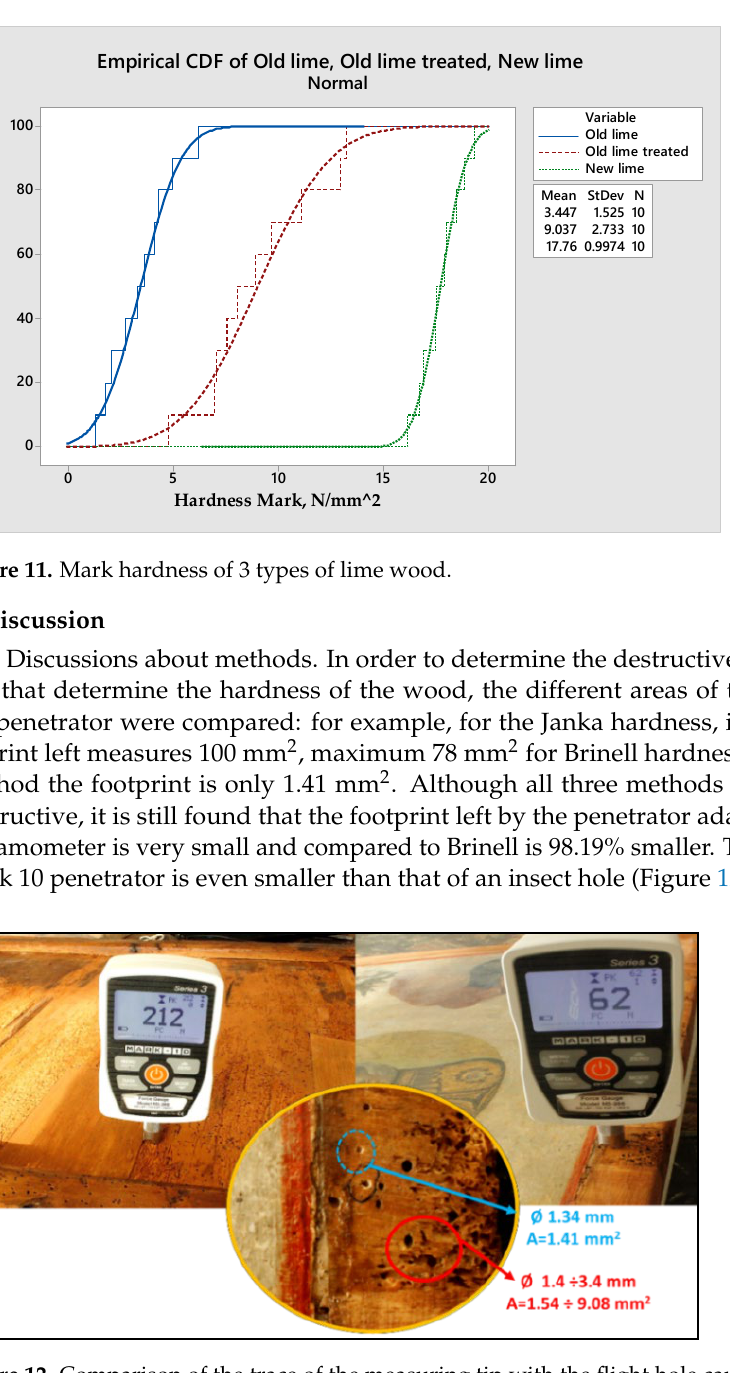
Figure 12. Comparison of the trace of the measuring tip with the flight hole caused by xylophagous insects: Mark 10 tip, Ø 1.34 mm A = 1.41 mm 2 , flight hole, Ø 1.4–3.4 mm, A = 1.54–9.08 mm 2.